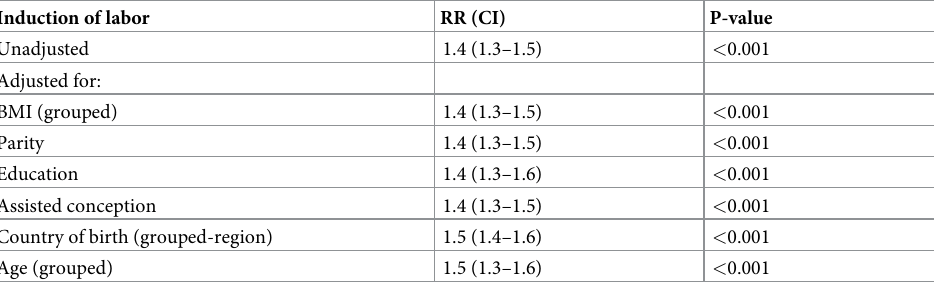
Table 3. Induction of labor among 672 women in the DFM-group in comparison to 4525 women in the reference group with adjustment for possible confounders by logistic